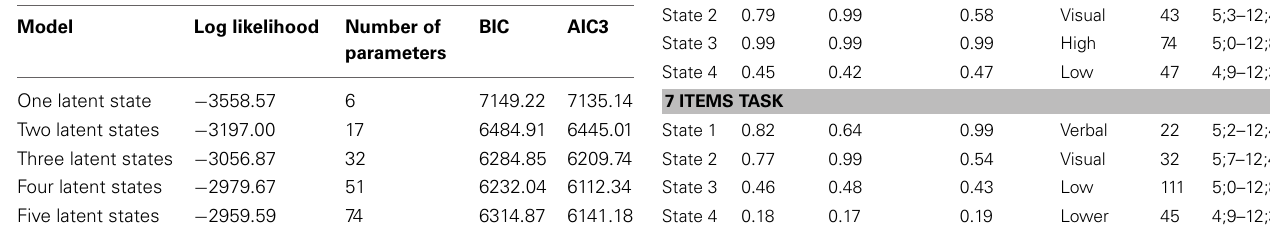
Table 1 | Fit statistics of the five fitted models.